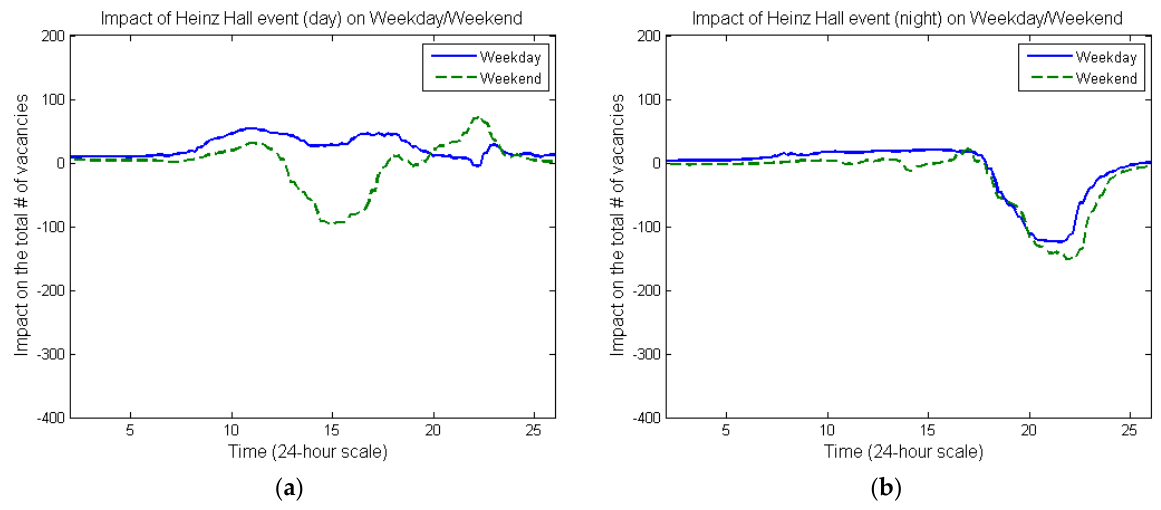
Figure 3. ( a ) Impact of Heinz Hall event during daytime; ( b ) impact of Heinz Hall event during nighttime.